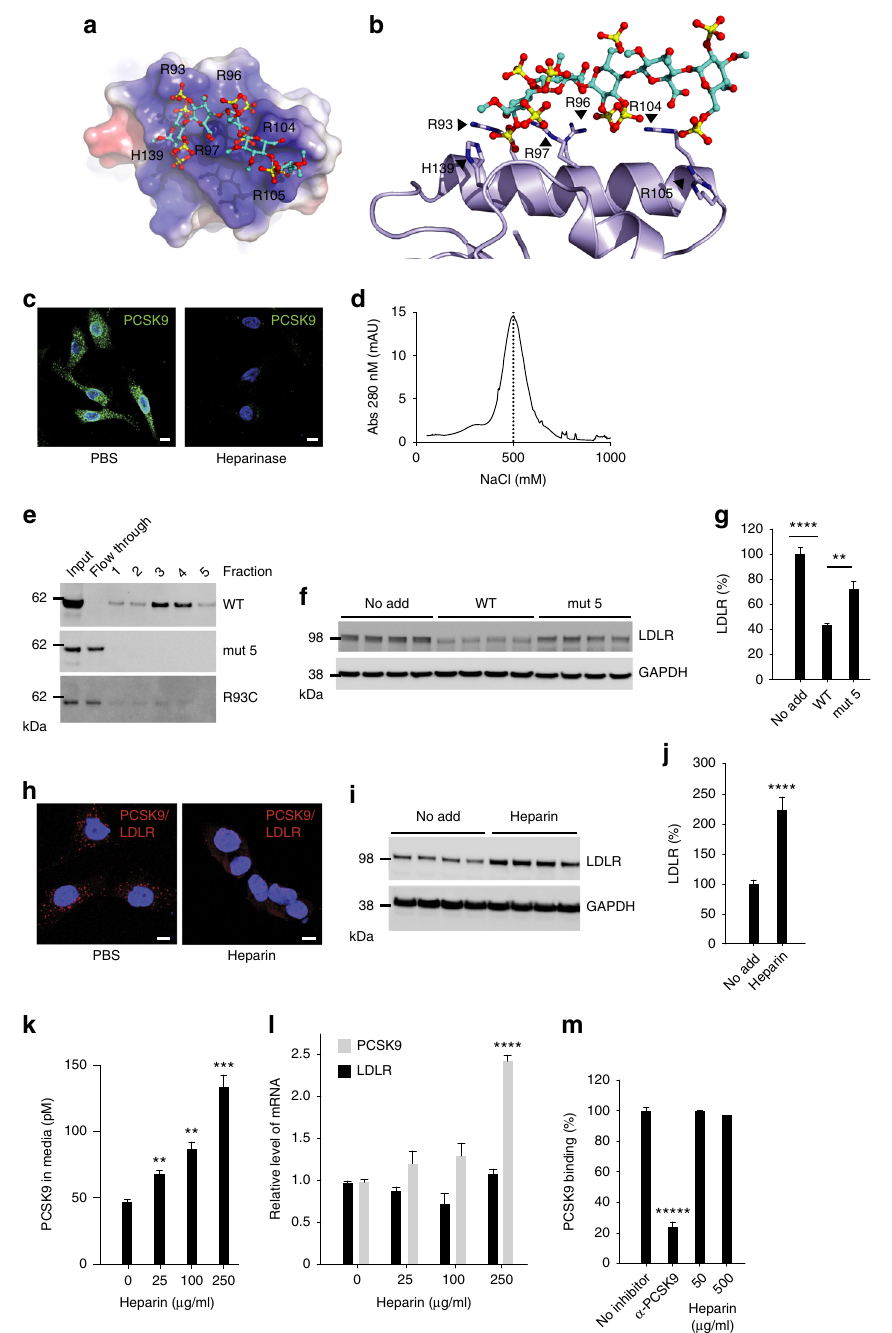
Fig. 1 PCSK9 cell surface binding and activity depend on HSPG. a A heparin pentasaccharide (SANORG, sticks) (PDB ID 1E03) 61 docked at the electrostatic surface ( red negative; blue positive) of the HSPG-binding site in PCSK9 (PDB ID 3H42) 26 with positively charged amino acids (R: arginine, H: histidine) indicated. b Superposition of SANORG with PCSK9 ( ribbon ). c Non-permeabilized HepG2 cells-expressing PCSK9 ( green ) after treatment with or without heparinase I. Nuclei were stained with Hoechst ( blue ). The experiment was repeated three times with similar results. d PCSK9 binding to heparin was analyzed by af fi nity chromatography. e PCSK9 mutant with all six amino acids highlighted in a , b substituted for alanines (mut 5) showed complete loss of heparin binding. Substitution of R93 alone for cysteine (R93C) also resulted in complete loss of heparin binding. f , g HepG2 cells incubated 18 h with WT PCSK9 and PCSK9 mut 5 (10 nM of each, n = 4). h PLA analysis of non-permeabilized HepG2 cells showed that co-localization of LDLR and PCSK9 was markedly reduced upon incubation of cells with heparin (500 µ g/ml). The experiment was repeated three times with similar results. i , j LDLR levels in HepG2 cells following incubation with heparin (500 µ g/ml, 18 h, n = 4). k Heparin treatment resulted in accumulation of PCSK9 in the culture